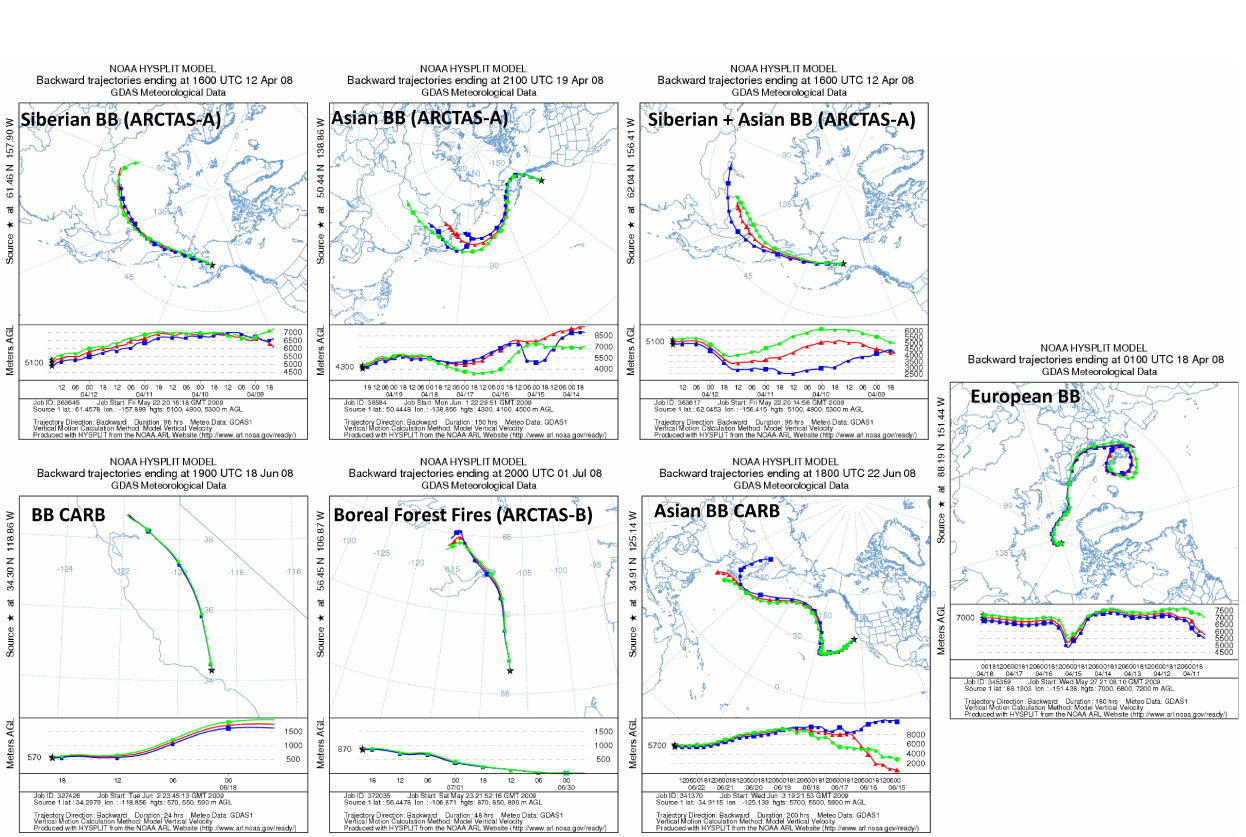
Fig. 2. Typical HYSPLIT back trajectory analysis results for some of the major plume